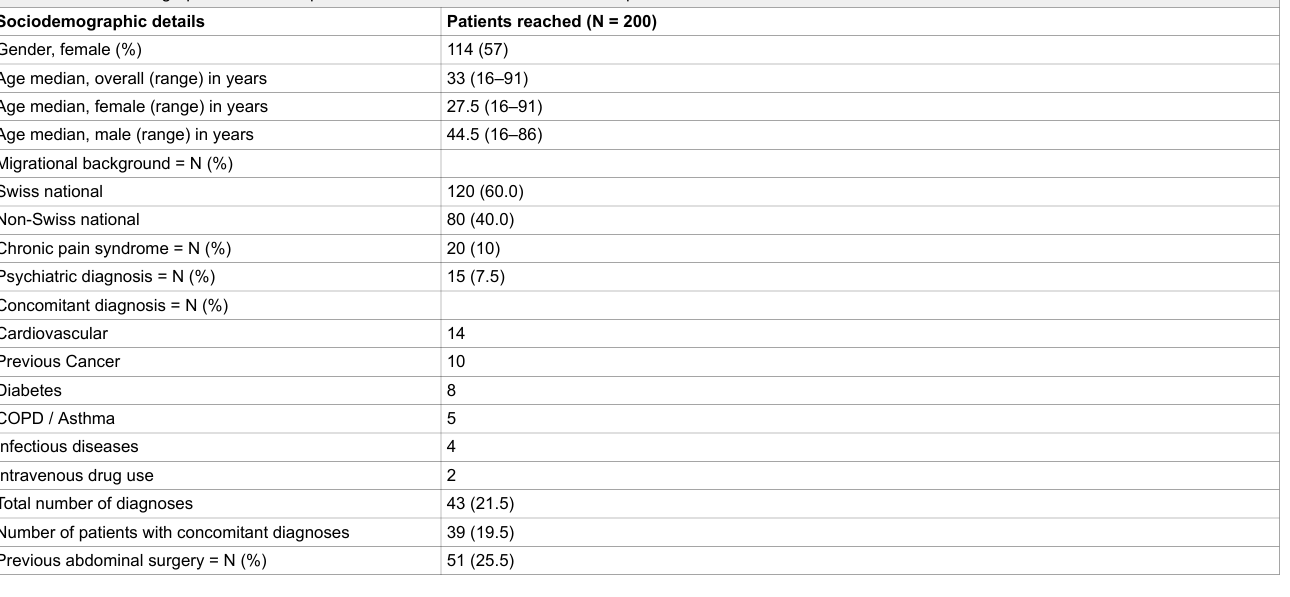
Table 1: Patient demographics of the 200 patients who could be reached for follow-up. Sociodemographic details